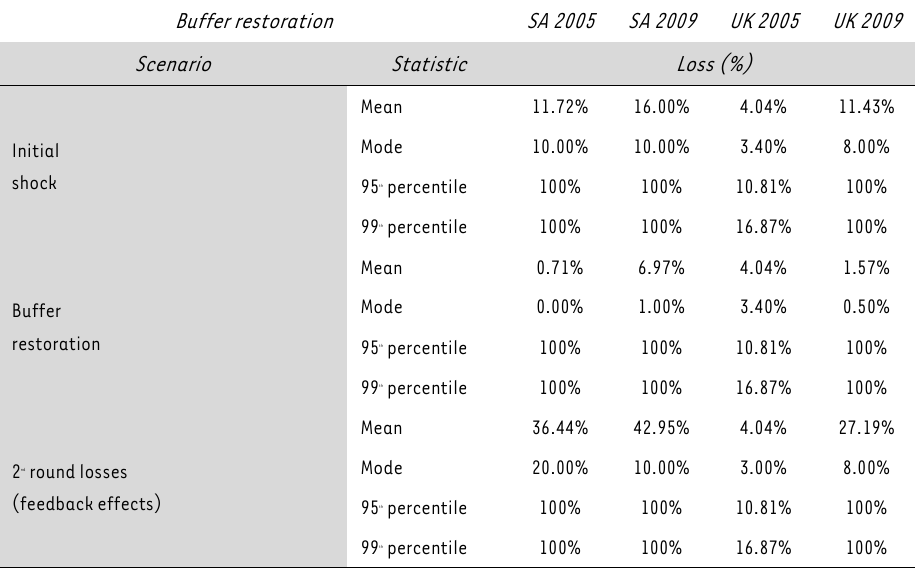
FIGURE 16: UK 2009, buffer restoration model illustrating haircut factors Source: Authors’ analysis TABLE 4: Loss statistics for LST models affected by increased haircuts for both economies in both